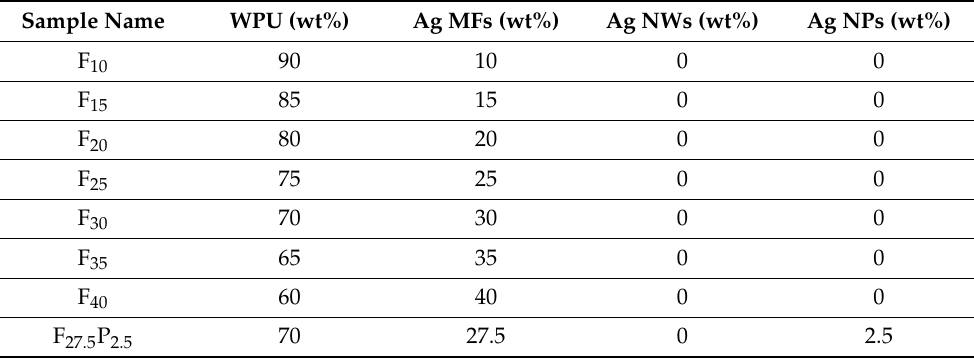
Table 8. Sample names of conductive silver pastes with different amounts of